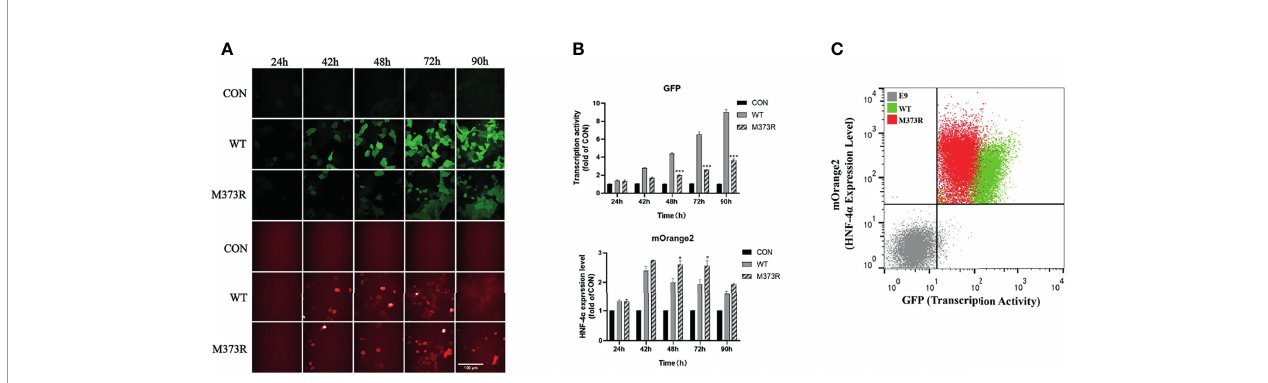
FIGURE 2 | Optimization of the assay in the single-cell clone HEK293T_pHNF1AP_E9 stably expressing the pHNF1A-GFP reporter. (A, B) Kinetic performance of this assay in HEK293T_pHNF1AP_E9 cells transiently transfected with HNF-4 a or mutant M373R. Data were the means of triplicate fi elds from one experiment and were conducted twice independently; error bars show s.d. *p < 0.05, ***p < 0.001. Scale bar: 50 m m. (C) Sorting of HEK293T_pHNF1AP_E9 (E9) cells expressing wide-type HNF-4 a (WT, green color) or M373R (M373R, red color) populations, negative control: HEK293T_pHNF1AP_E9 (gray color). The transcription activity of mutant M373R was signi fi cantly lower than that of wild type, p < 0.0001.